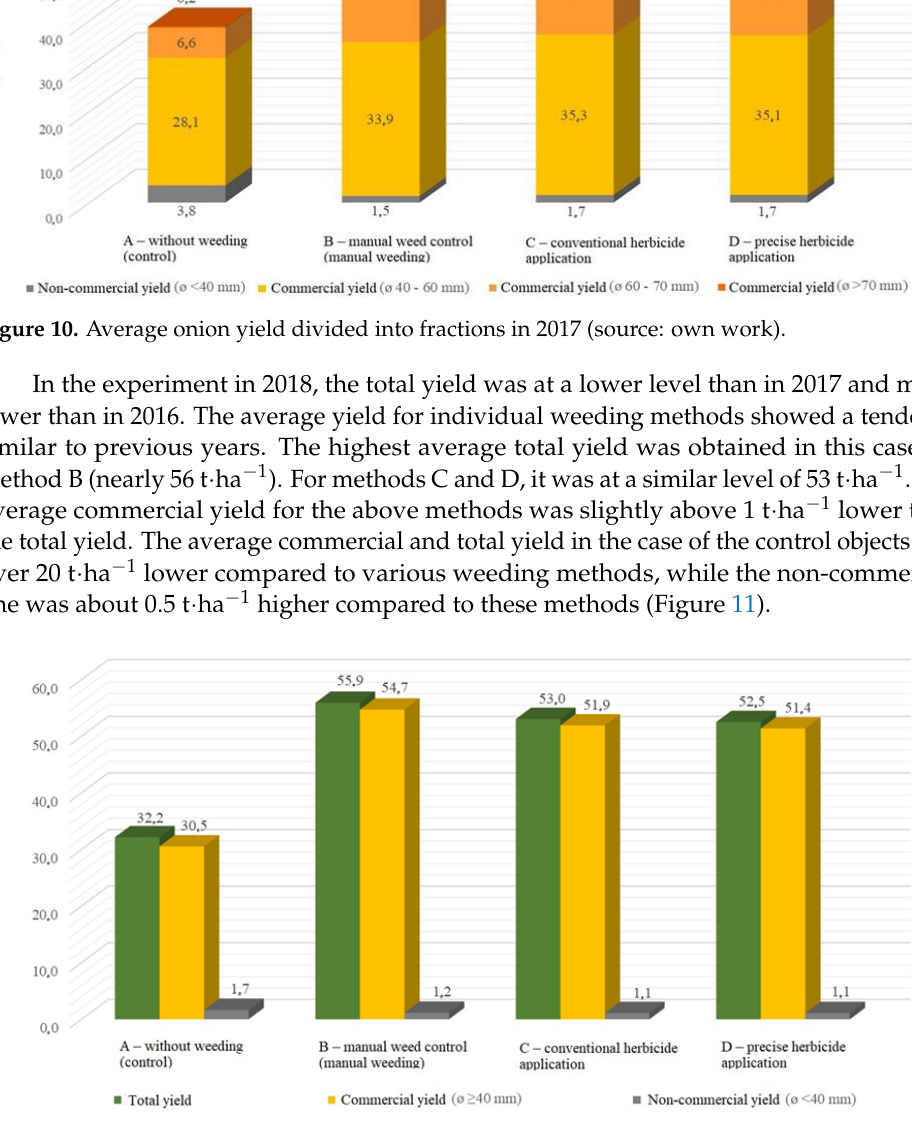
Figure 11. Average onion yield in 2018 (source: own work). In 2018, the different weeding methods did not differ statistically in terms of total yield. Only the control objects showed a statistically lower yield (Figure 12). The yield distribution was also similar in the case of commercial yield, where only control objects yielded a lower level (Figure